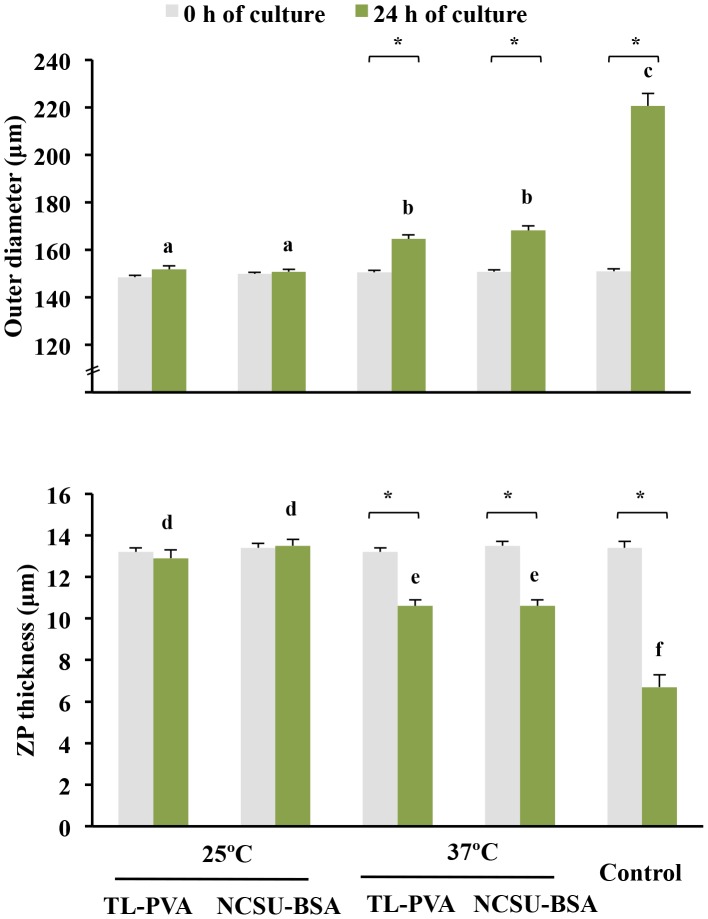
Outer diameter and zona pellucida (ZP) thickness (means ± S.E.M.) of in vivo-derived morulae cultured for 24 h using different temperatures and media.Morulae were cultured in closed Eppendorf tubes containing 1.5 mL of TL-PVA or NCSU23-BSA media, supplemented with 10 mM HEPES, at 25°C or 37°C. Controls were morulae cultured in 4-well multi-dish plates, with each well containing 500 µL of NCSU-23 medium supplemented with BSA and fetal calf serum, at 38.5°C in humidified air with 5% CO2. Different letters represent differences (a, b, c: p<0.002; d, e, f: p<0.02) in embryo diameter and ZP among groups. Asterisks indicate differences (P<0.001) between 0 h and 24 h of culture within each group.